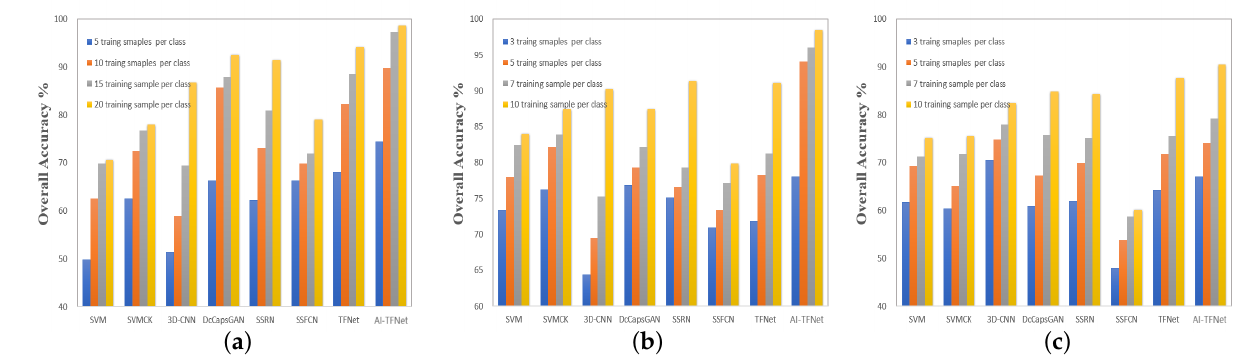
Figure 10. The overall accuracy of different methods on three datasets with different training sampling rate: ( a ) the University of Pavia dataset; ( b ) the Salinas dataset; and ( c ) the Houston